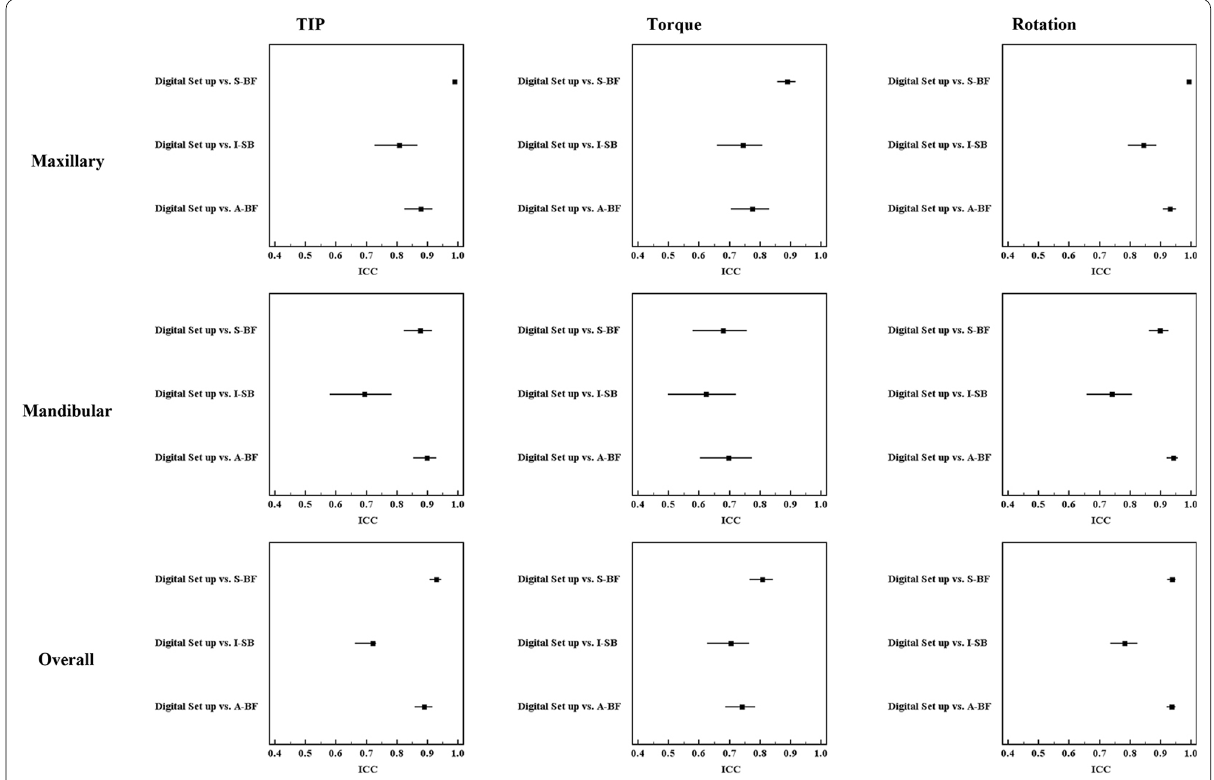
Fig. 3 Forest plots of ICC of agreement between registration software packages and the digital setup for tip, torque and